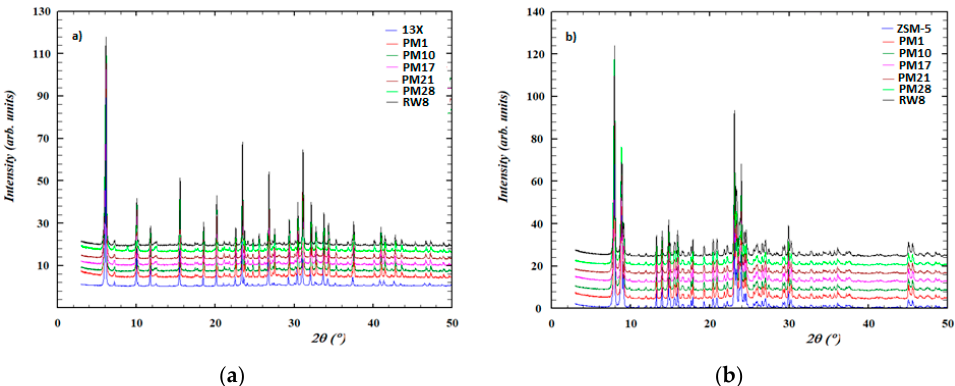
Figure 2. X-ray powders diffraction patterns of 13X ( a ) and ZSM-5 ( b ) zeolites after adsorption of water from different areas inside the SIN.